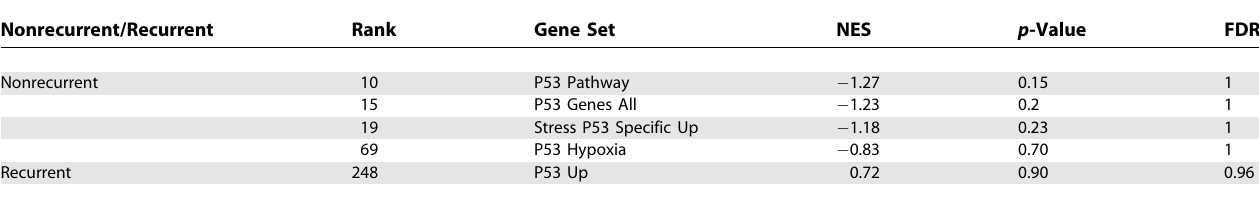
Table 2. GSEA Results for the P53 Gene Sets in the Recurrent/Nonrecurrent Breast Cancer Dataset Nonrecurrent/Recurrent